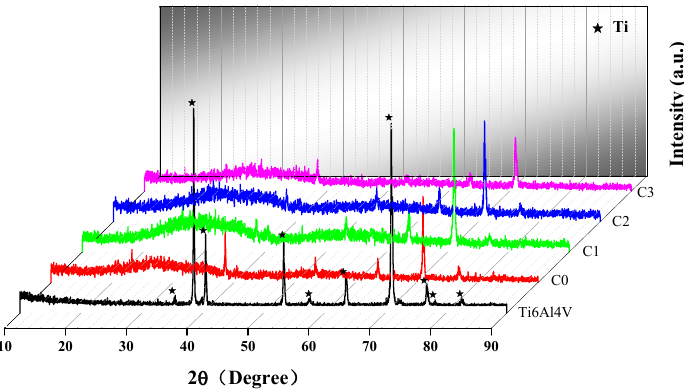
Figure 7. XRD patterns of coated and un-coatedTi6Al4V.